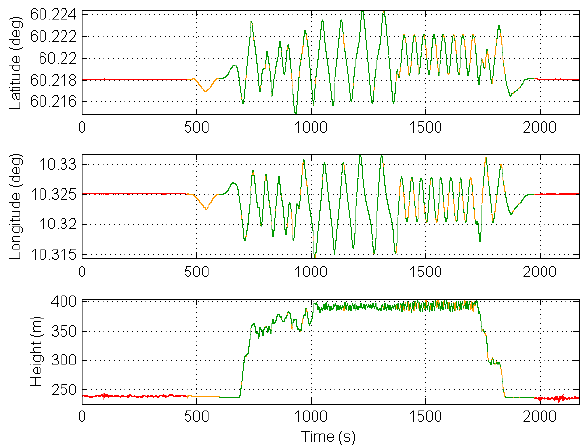
Figure 1. RTK position of UAV (Single: Red, Float: Yellow, Fixed: Green)